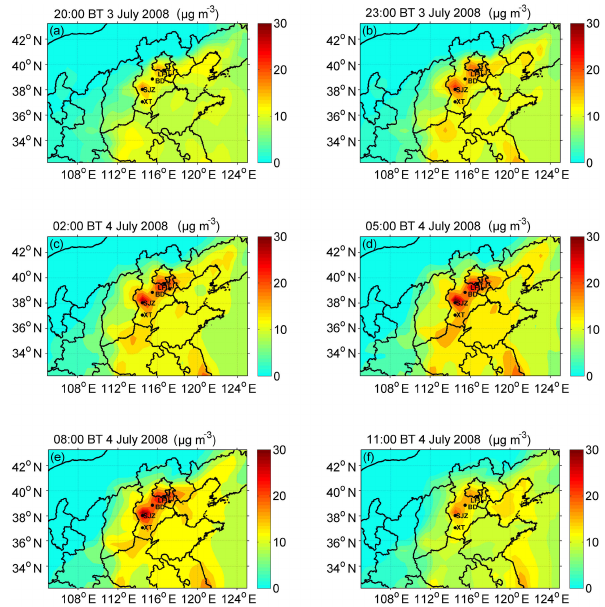
Figure 3. BC concentration distribution at ground level (Unit: µgm − 3 ) .